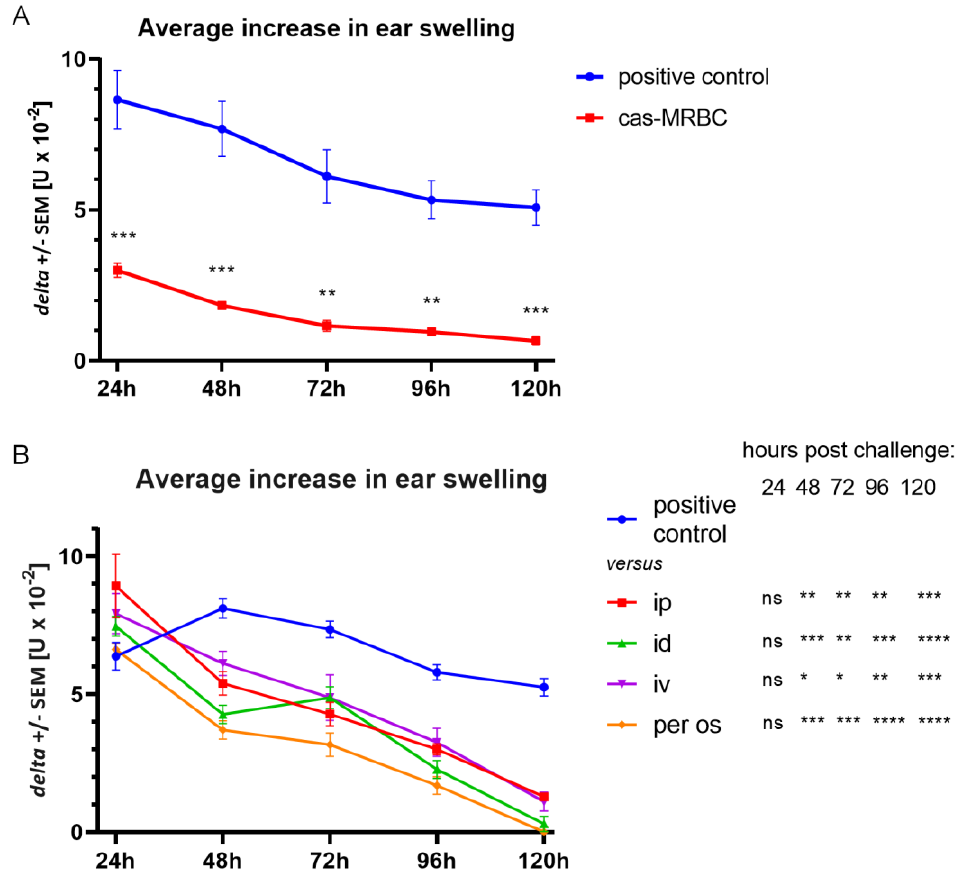
Figure 4. Suppression of delayed-type hypersensitivity (DTH) to soluble casein (Cas) antigen is induced by intravenous (iv) injection of Cas-coupled syngeneic red blood cells and by